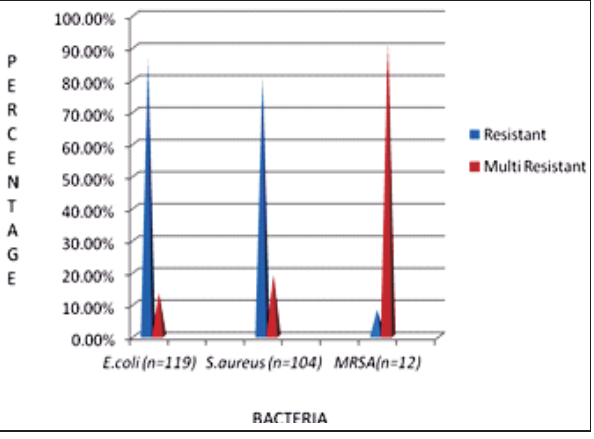
Figure-1. Incidence of resistance mastitis in cows bials and few isolates (13.45%) were found to be multi-drug resistant (Figure-1) i.e resistance to 3 or more of antimicrobials. isolates were most sensitive to enroflo- xacin (79.8%) followed by gentamicin (71.2%), amoxicillin and sulbactam (69.2%) and ceftriaxone (69.2%t). The isolates showed highest resistance to penicillin (63.5%) followed by amoxicillin (61.5%), oxytetracycline (49%) and methicillin (52.9%). Most of the us isolates (80.77%) were found to be resistant i.e resistance to 1 or 2 antimicrobials isolates (19.23%) were found to be multi- drug resistant (Figure-1) i.e resistance to 3 or more antimicrobials.